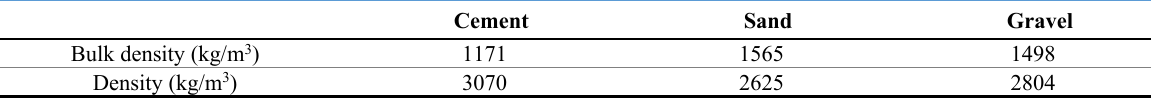
Table 1 – Properties of materials.